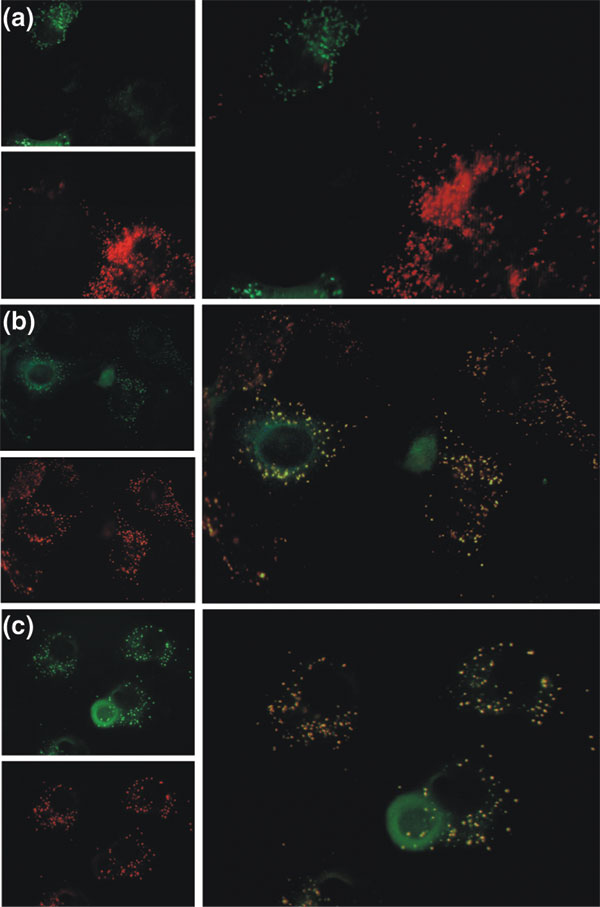
Targeting of GFP-tyrosinase and GFP-lysozyme to peroxisomes in human cells. Fluorescence of human COS7 cells expressing (a) GFP-lysozyme or DsRed2-SKL; (b) GFP-tyrosinase and DsRed2-SKL; or (c) GFP-lysozyme and DsRed2-SKL. Cells were observed 36 h after transfection (magnification 60 ×). Separate small images of the GFP fluorescence (green) and DsRed2 fluorescence (red) are shown to the left of each main picture, in which the two fluorescent images are overlaid. Areas in which red and green fluorescence coincide show as yellow. (a) Control experiments reveal that expression of GFP-lysozyme is an adjunct to the cellular punctuate fluorescence pattern independently of the presence of DsRed2-SKL. The figures show a punctate fluorescence pattern for GFP fusions with (b) human tyrosinase and (c) chicken lysozyme. Both proteins co-localize with DsRed2-SKL in human peroxisomes as demonstrated by the fluorescence overlay. Owing to the evolutionary conservation of PEX5 within the metazoans [7,13,33], a chicken protein (lysozyme) can be assayed in a human cell line and the species barrier is not an issue in this study.